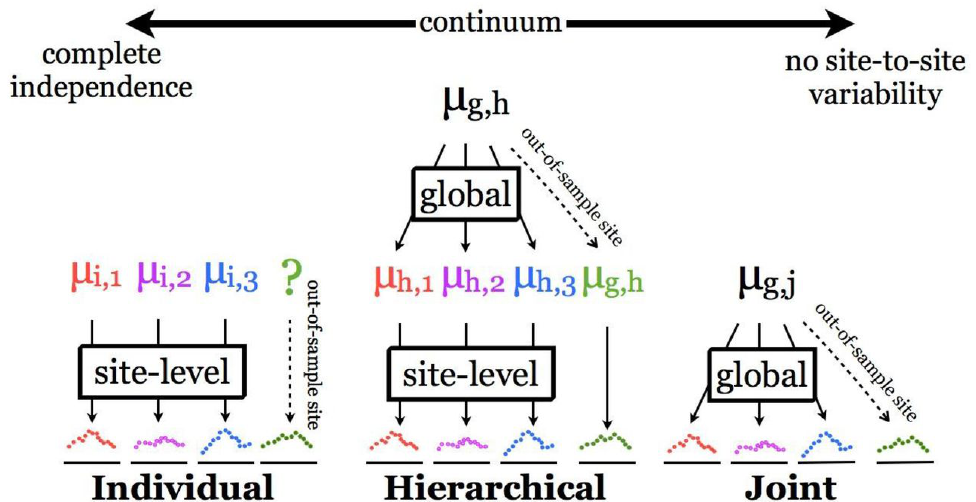
Figure 3. Graphical representation of different optimization schemes explored in this study to constrain model parameters, as adopted from